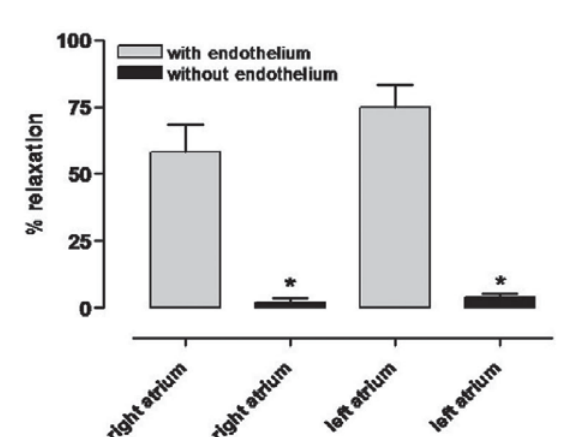
Fig. 5 - Bioassay of calcium ionophore-induced promote relaxation in the right and left atrium. The vasodilator activity of effluent from the right and left atrium was blocked 97.1 + 2.9% and 95.9 + 2.5%, respectively by endothelium removal in rings contracted with PGF2 α (2x10-6M). Results are reported as means + SEM. * indicate significant difference between with and without endothelium ring (P <